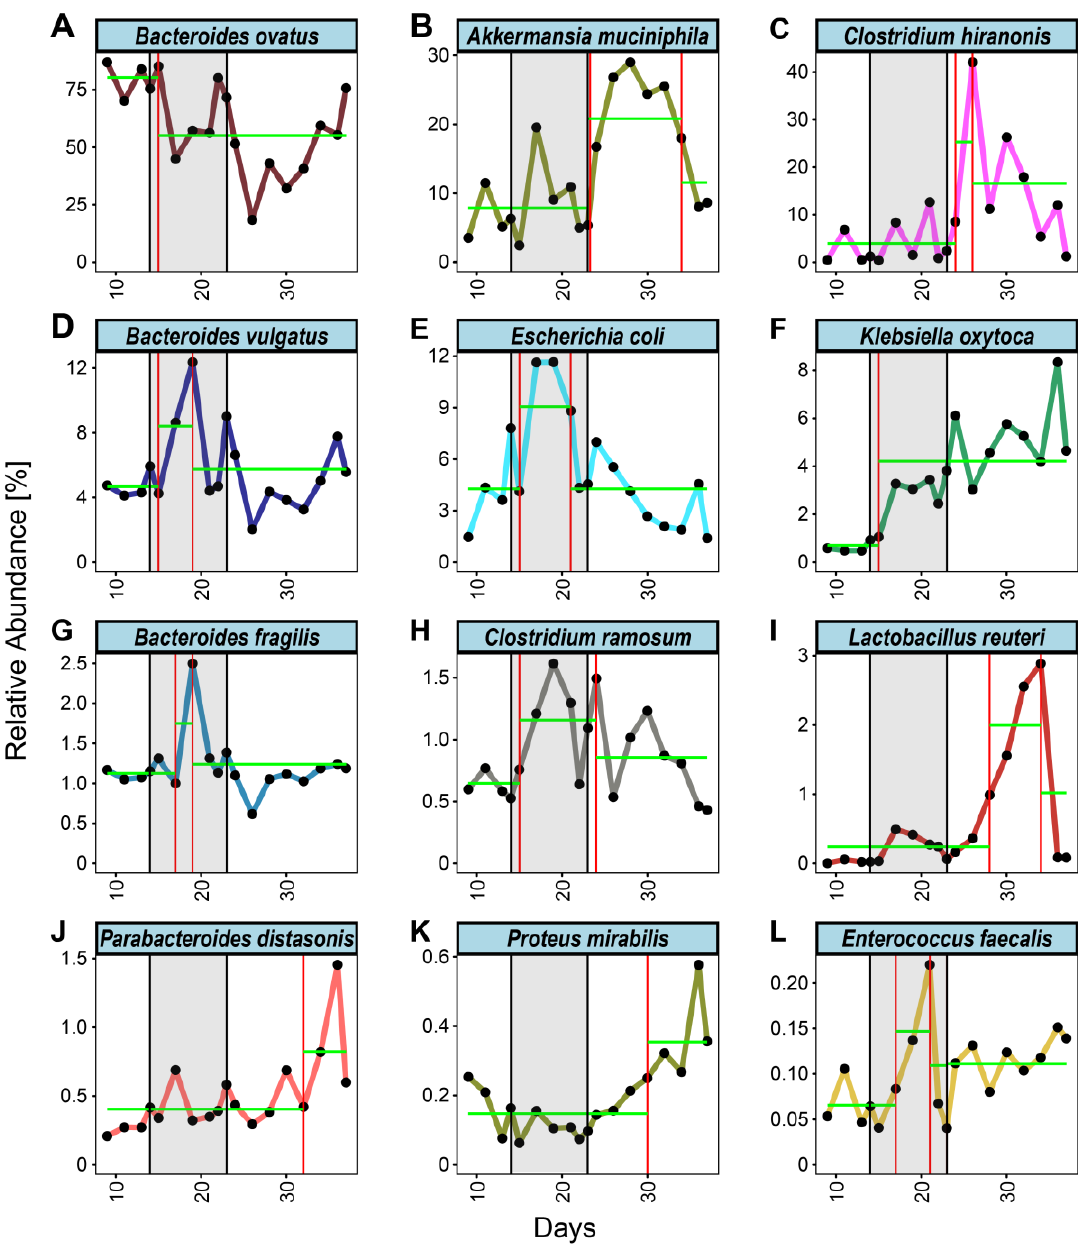
FIGURE 3: Change point analysis of mean relative abundances throughout the experiment. (A-L) Longitudinal depiction of the mean rela- tive abundance throughout the experiment for the 12/15 bacteria that persistently colonized the gnotobiotic mice and were regulated in response to the CJE treatment. Change points are indicated with a red vertical line, segments are indicated with a green horizontal line. Figures for individual replicates are in the Supplementary Figures, a summary of changes and directions can be found in Table 1